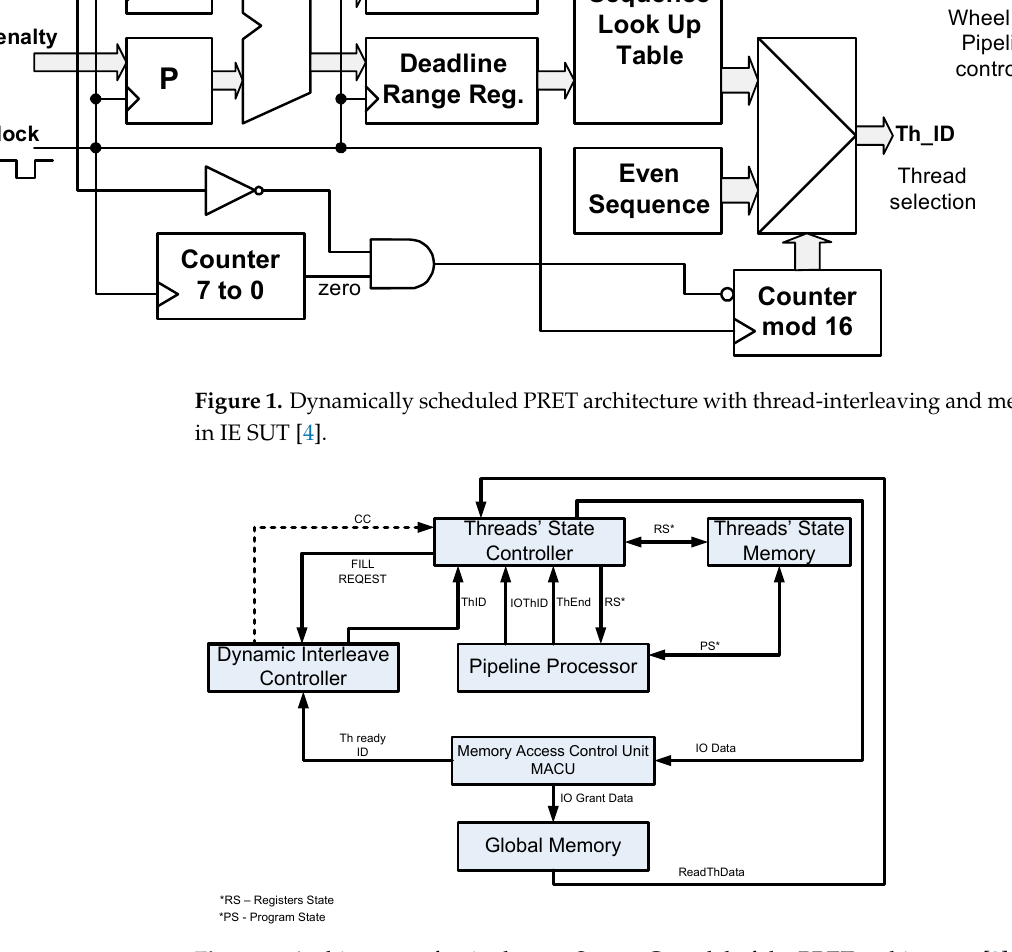
( b ) Figure 3. Structure of a classical simple processor ( a ) and subsequent instruction’s cycles ( b ). 3.2. Simple Core with Clock-Gating Mechanism (STP CG) The modification of the previous solution is depicted in Figure 4. In this structure, a clock gating technique [14,24] was used to efficiently use only those resources that are needed in a given phase of the processing. In the presented structure the clock signal is selectively blocked, i.e., only the modules utilized in the currently performed phase of the instruction cycles are clocked, whilst the clock signal is blocked to the rest of those pro- cessor resources belonging to inactive phases in a given moment. As is presented below, this modification allows radically reducing the dynamic power dissipated in the core.